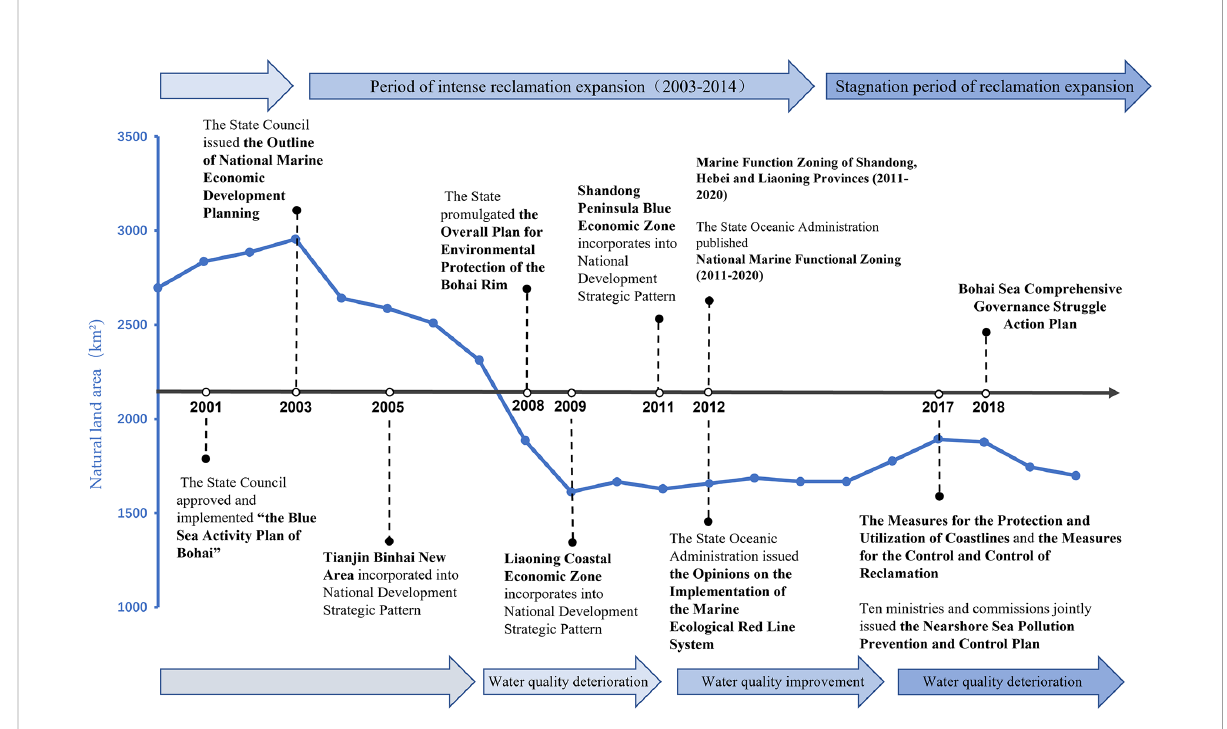
FIGURE 9 Development of coastal zone and changes in protection policies in the Circum-Bohai Coastal